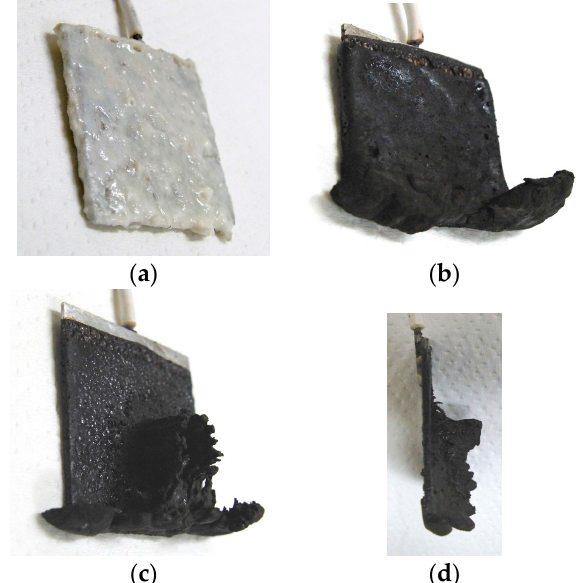
Figure 2. Photographs of electrolytically polymerized rubber: ( a ) NR-latex without application of a permanent magnet; ( b ) MCF rubber without application of a permanent magnet; ( c ) MCF rubber with application of a permanent magnet; ( d ) image from viewing transversely to the electrode of (c). NR-latex or MCF rubber solidified and attached to an anode electrode after electrolytic polymerization under the conditions in which the electrodes are immersed transversely in a container (see Figure 1).